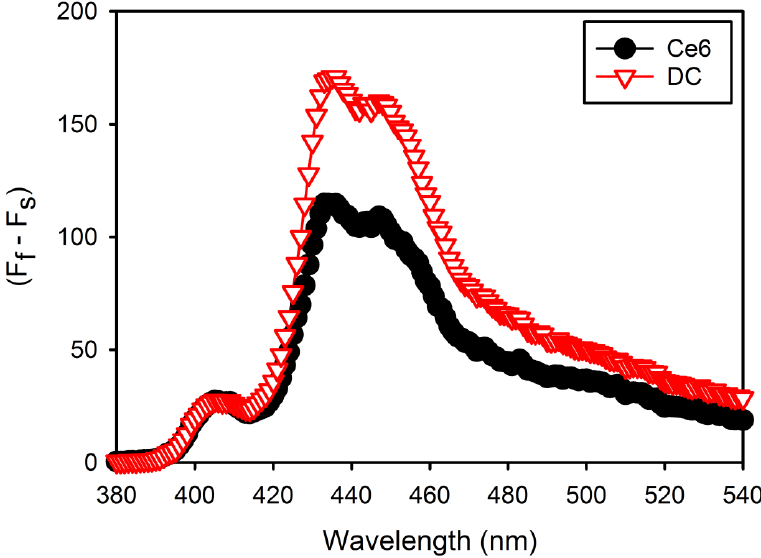
Figure 4. 9,10-Dimethylnathracene (DMA) fluorescence change (F f − F s ) due to singlet oxygen generation by free Ce6 and DC after laser irradiation in Dulbecco’s phosphate-buffered saline (DPBS) (pH 7.4), where F f and F s represent the fluorescence intensity of full DMA and each sample.